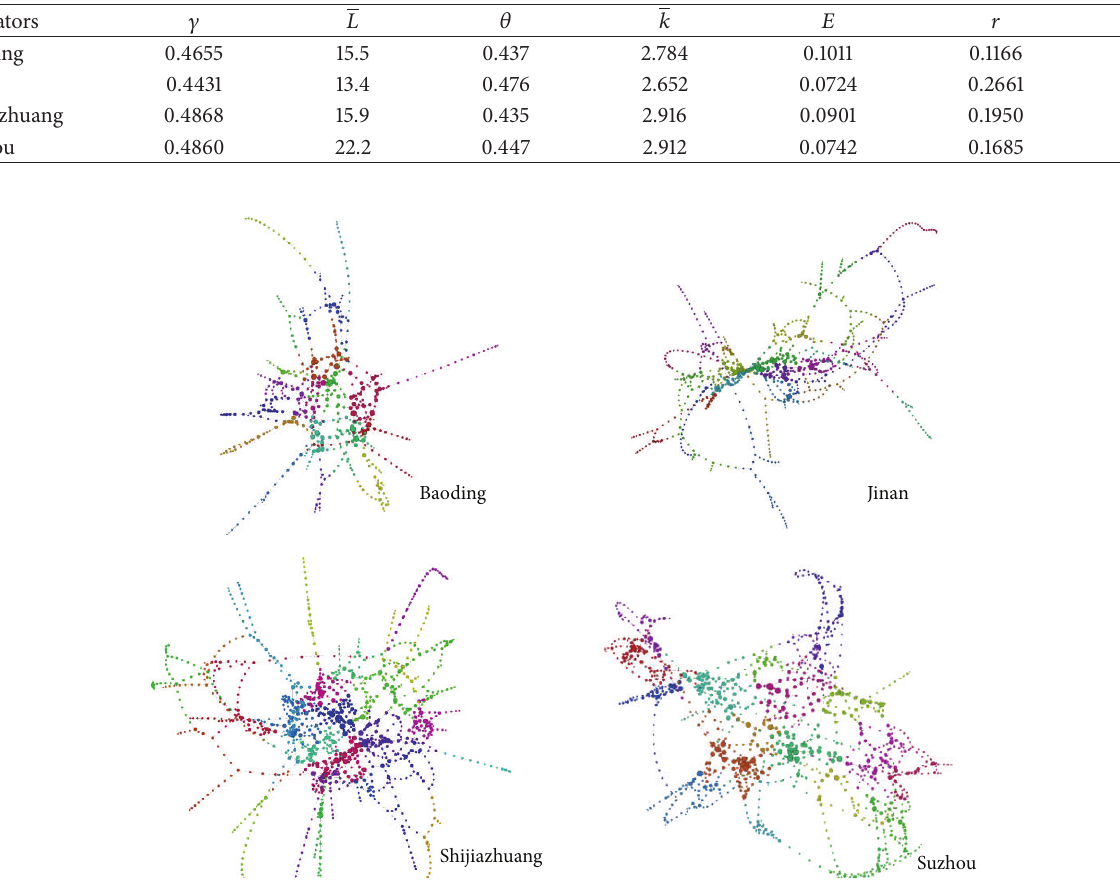
The average degree of Baoding, Jinan, Shijiazhuang, and Suzhou is 2.784, 2.652, 2.916, and 2.912, which is slightly larger than subway networks